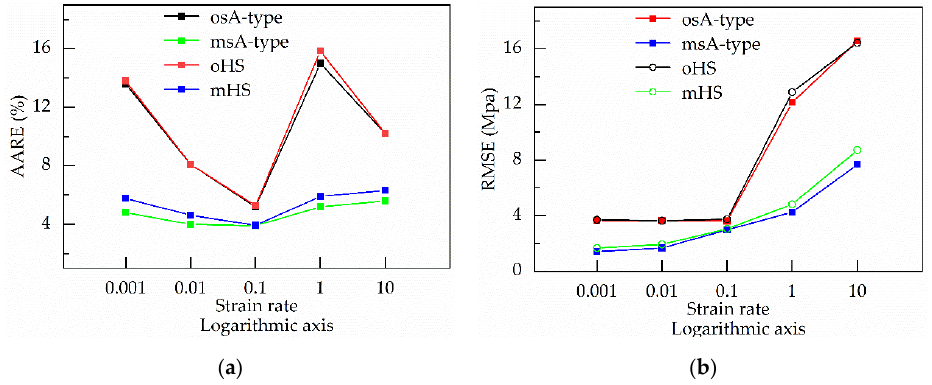
Figure 17. The relationship between the strain rate and ( a ) AARE; ( b ) RMSE obtained by the original strain-compensated Arrhenius-type (os–cA-type) equation, the modified strain-compensated Arrhenius-type (ms–cA-type) equation, the original Hensel–Spittel (oHS) equation and the modified Hensel–Spittel (mHS) equation. Based on the above result, it is found that the original strain-compensated Arrhenius-type (os–cA-type) equation and the original Hensel–Spittel (oHS) equation have a similar and relatively lower prediction accuracy. The prediction accuracy of the modified strain-com Arrhenius-type constitutive equation is the highest, which is slightly higher than the prediction accuracy of the modified Hensel–Spittel (mHS) equation. Table 5. R, AARE, RMSE and RE of the original strain-compensated Arrhenius-type (os–cA-type) equation, the modified strain-compensated Arrhenius-type (ms–cA-type) equation, the original Hensel–Spittel (oHS) equation and the modified Hensel–Spittel (mHS) equation. Constitutive Equation